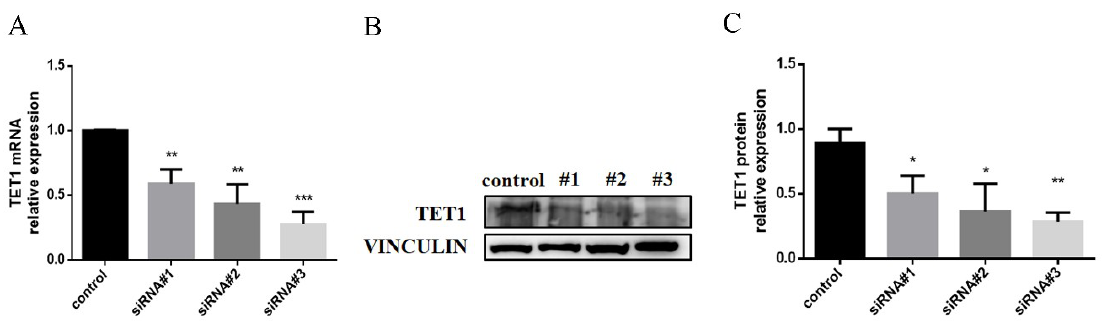
Figure 4. The effect of the siRNA-mediated depletion of TET1 expression in THP-1 cells. The mRNA ( A ) and protein ( B,C ) expression of TET1 was measured by qRT-PCR and Western blot analysis in THP-1 induced macrophages following siRNA treatment. VINCULIN was used as an internal control. All of the results represent the mean ± standard deviation of three independent experiments ( n = 3). * p < 0.05, ** p < 0.01, and *** p < 0.0001 represent significant di ff erences compared with the